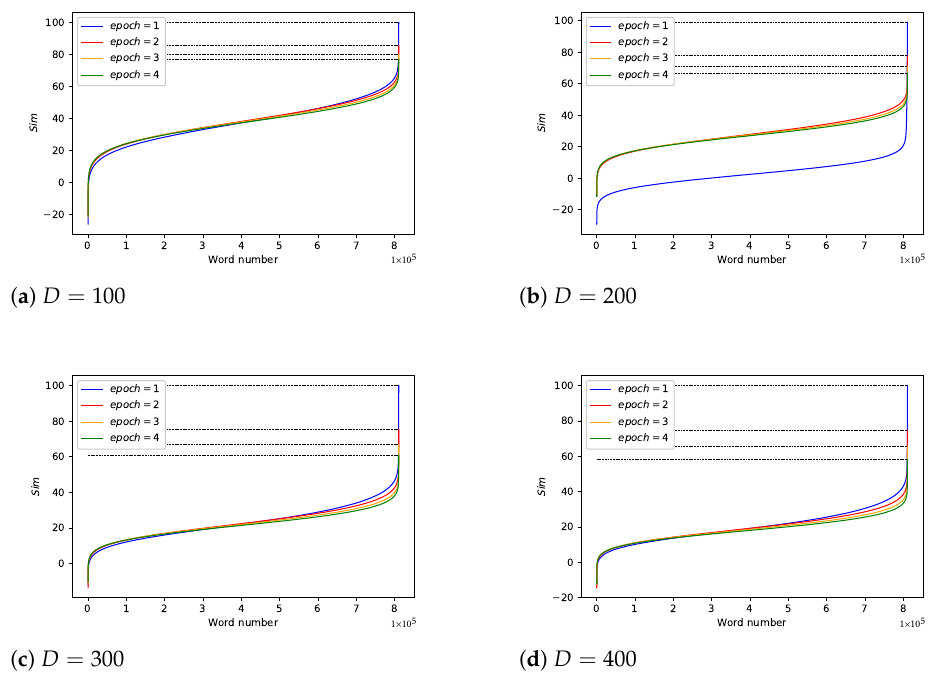
Figure 12. Correlation (measured by sim ) as D and epoch